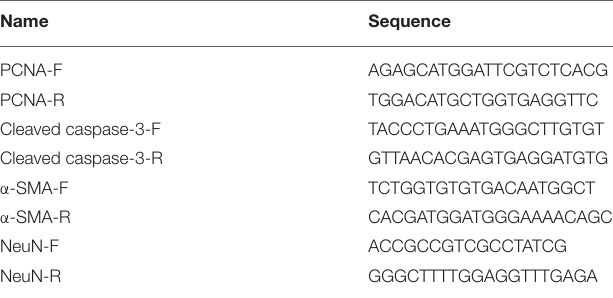
TABLE 2 | Sequences Used for qPCR.